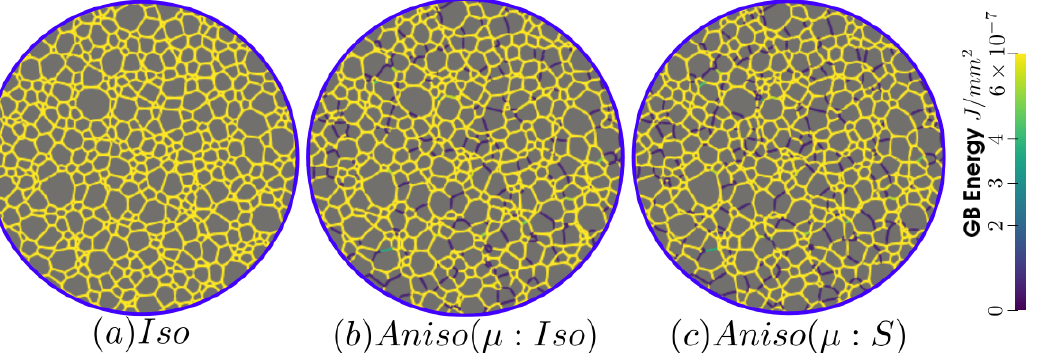
Figure 16. Disorientation distribution obtained including TBs at ( a ) t = 1 h and ( b ) t = 2 h for the isotropic (Iso) formulation, anisotropic formulations with isotropic GB mobility (Aniso( µ :Iso)) and heterogeneous GB mobility (Aniso( µ :S)), and the experimental data (EBSD). The Y-axis represents the GB length percentage.